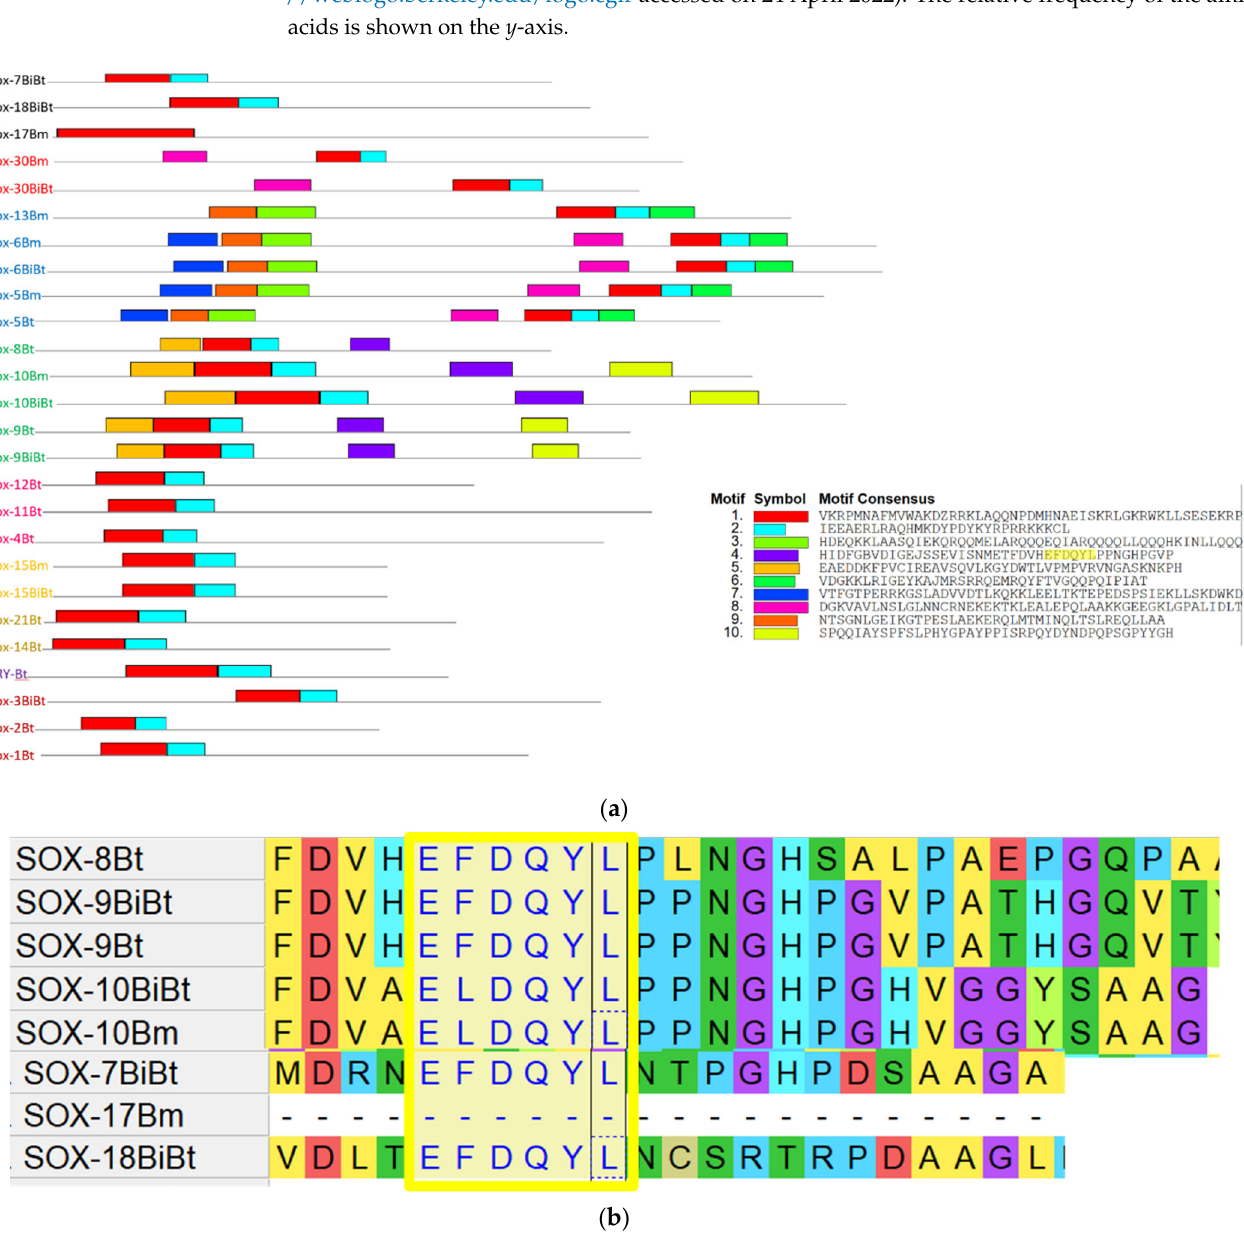
Figure 6. ( a ) Motif patterns of Bos Sox gene family. Ten differentially conserved motifs are indicated with differently colored boxes using the online Multiple Expectation Maximization for Motifs Elicitation (MEME, http://alternate.meme ‐ suite.org accessed on 12 June 2022) program. M4 included an important motif, which was highlighted in yellow. ( b ) Multiple sequence alignment of Sox genes in Bos sp (Bt: Bos taurus, BiBt: Bos indicus x Bos tautus, and Bm: Bos mutus) showing conserved trans ‐ activation motif highlighted in yellow. The motif is conserved in Sox 7–10 and 18 but not Sox 17. Amino acids colors were assigned by MEGA software based on their biochemical properties. Red, acidic; yellow, non ‐ polar neutral; cyan, positive polar basic; blue, positive polar; green, neutral po ‐ lar; purple, neutral non ‐ polar; lime, neutral polar).